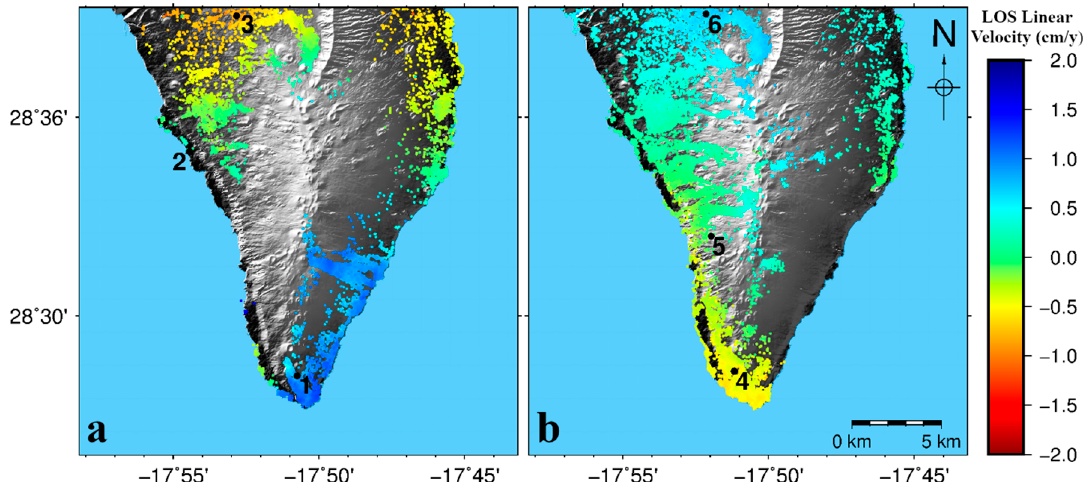
Figure 6. LOS linear velocity results for La Palma Island using the CPT A-DInSAR technique applied to ENVISAT radar images for the period 2006–2010. Displacements are in cm / year. ( a ) Results for ascending ENVISAT radar images and ( b ) descending ENVISAT radar images. Numbers 1–6 mark the locations of the selected pixels for which the LOS time series are shown in Figure 7. Positive values indicate pixels that move toward the satellite and negative values correspond to pixels that move away from the satellite.